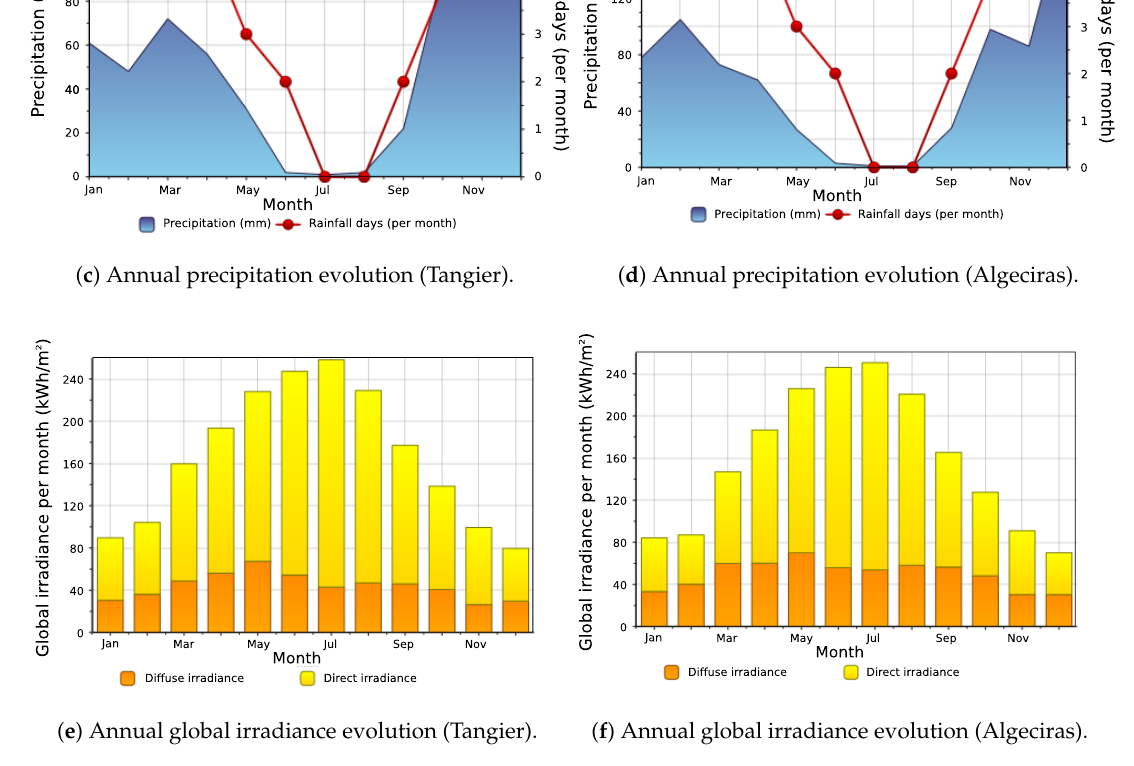
Figure 6. Meteorological data comparison: Tangier (climate zone Z2 , Morocco) vs. Algeciras (climate zone A3 ,